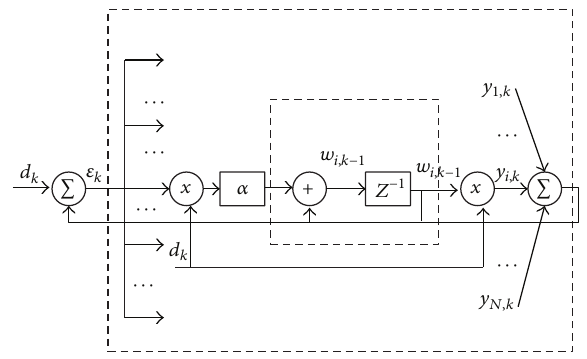
Figure 2: The diagram of adaptive noise